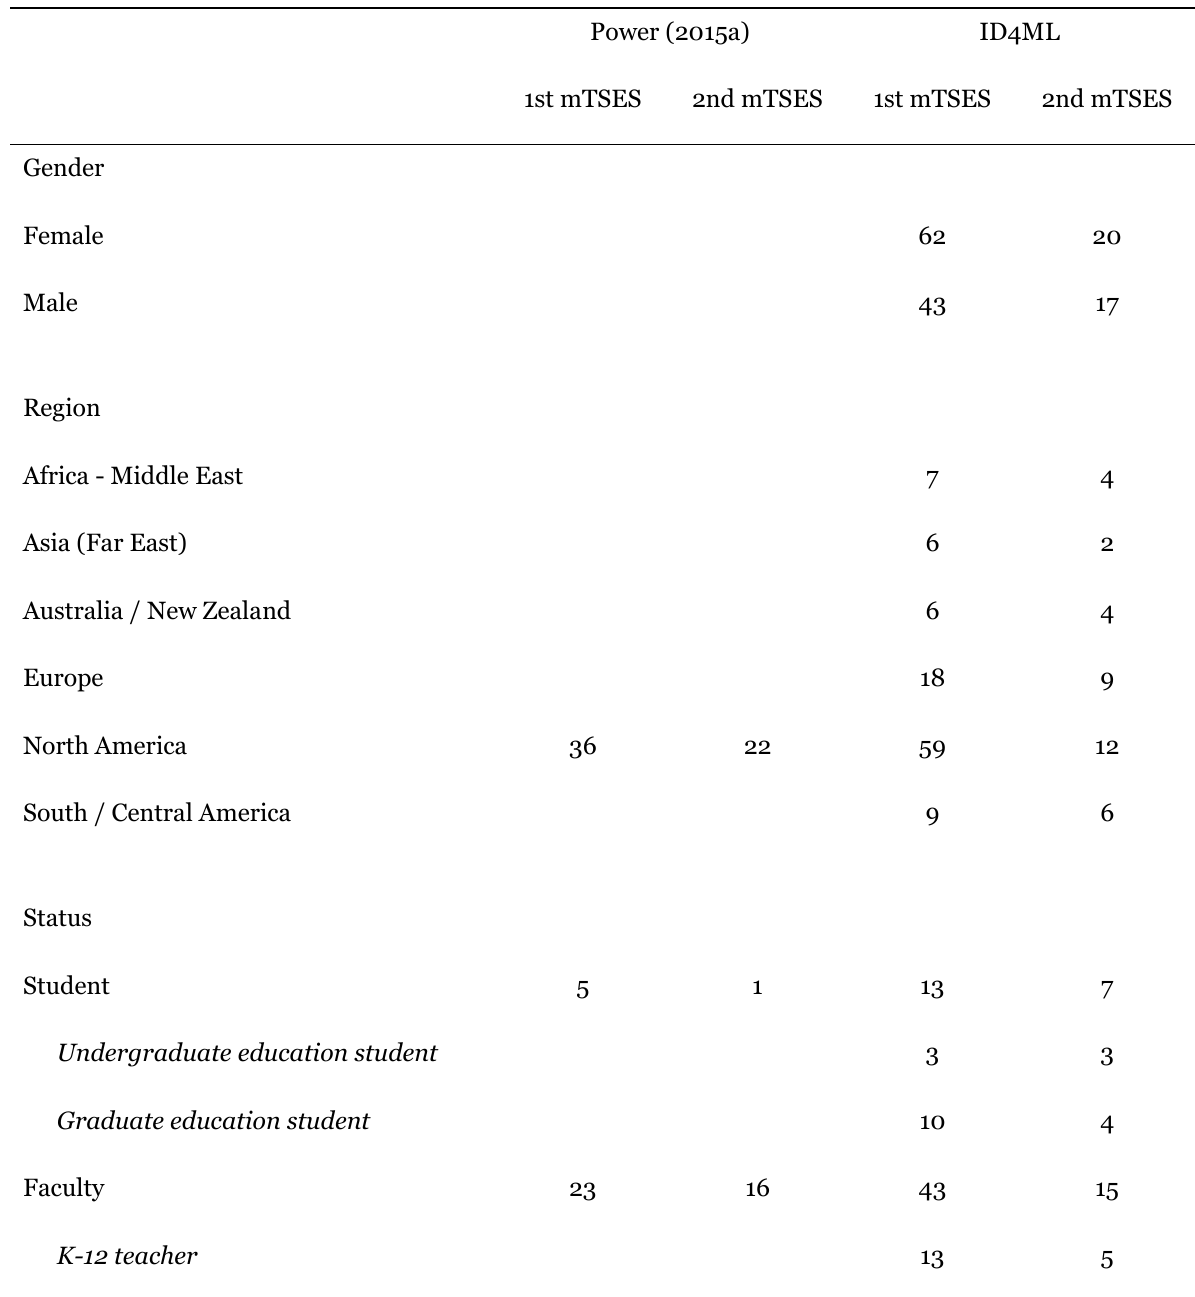
Demographic Breakdowns of Participants in Power (2015a) and